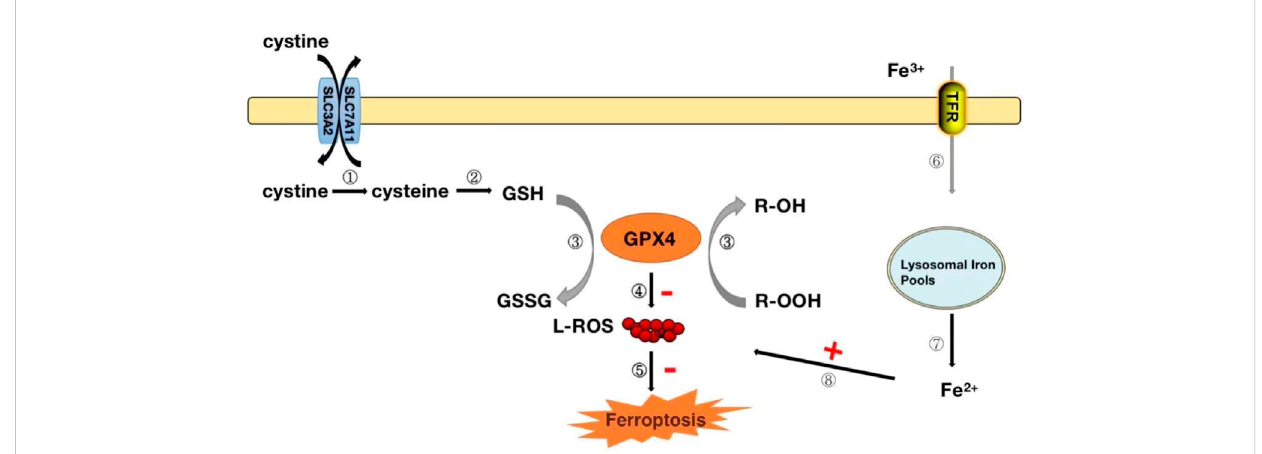
FIGURE 4 GPX4 modulates themechanismof irondeath.Steps ① - ② :After thecystine outside thecell entersthecell, itisrapidly converted to cysteine for the synthesis of glutathione (GSH). Step ③ : GPX4 converts reduced glutathione (GSH) to oxidized glutathione (GSSG) while reducing toxic lipid peroxide (R-OOH) to non-toxic alcohol (R-OH). Steps ④ - ⑤ : Inhibit the production of reactive oxygen species and organize the occurrence of ferrozoticosis, on thecontrary, whenthe activity ofGPX4 is reduced, it will promotetheformation of ROS and induce theoccurrence of ferrozoosis; Steps ⑥ - ⑧ :The circulating Fe 3+ enters the cell via transferrin and is reduced to Fe 2+ , which when Fe 2+ is excessive, can lead to the accumulation of ROS and induce the occurrence of ferrozoticosis.